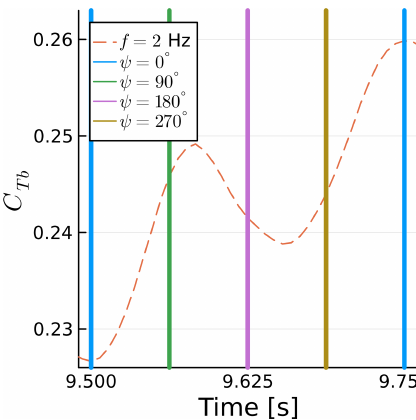
Figure 18. Azimuth convention used. Blade shown at ψ = 270 ◦